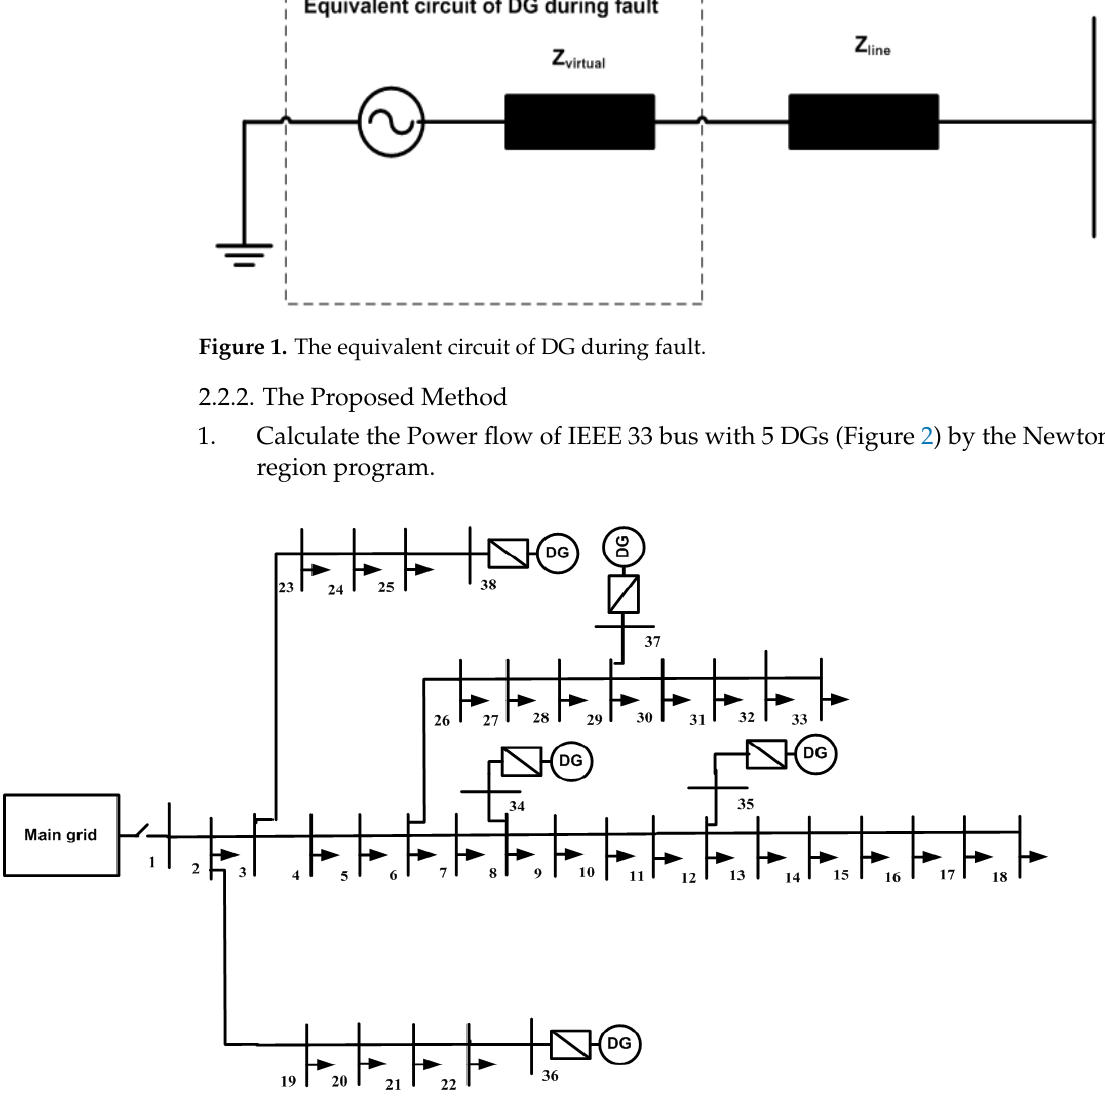
Figure 2. IEEE 33 bus with 5 DGs Isolated Microgrid.